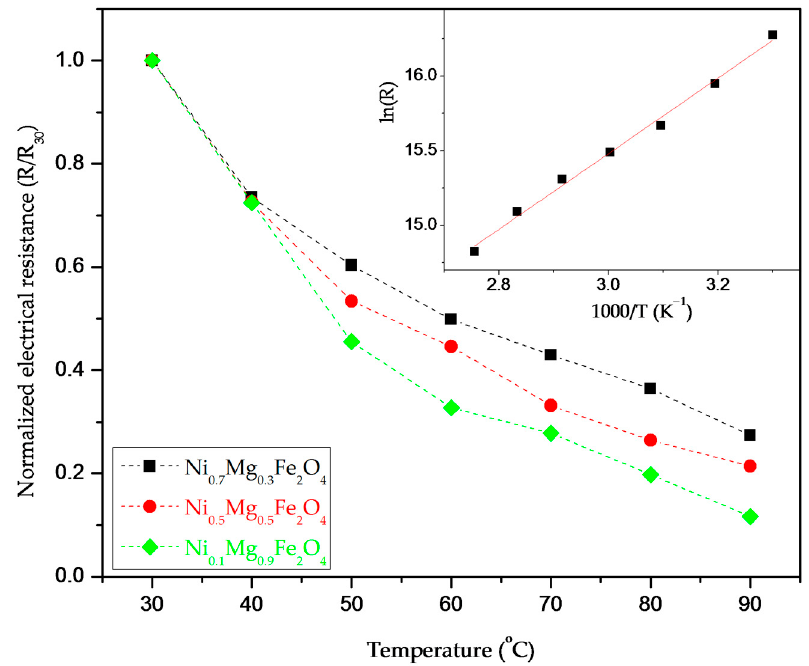
Figure 8. Change of DC resistance of Ni 0.7 Mg 0.3 Fe 2 O 4 , Ni 0.5 Mg 0.5 Fe 2 O 4 and Ni 0.1 Mg 0.9 Fe 2 O 4 in the temperature range of 30–90 °C; inset represents estimation of the material constant for Ni 0.7 Mg 0.3 Fe 2 O 4 .